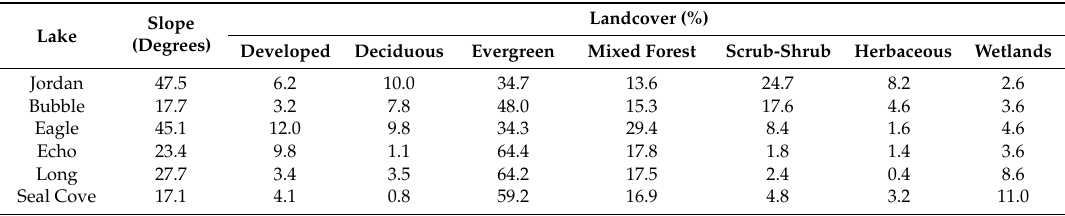
Table 3. Landscape characteristics for each of the six